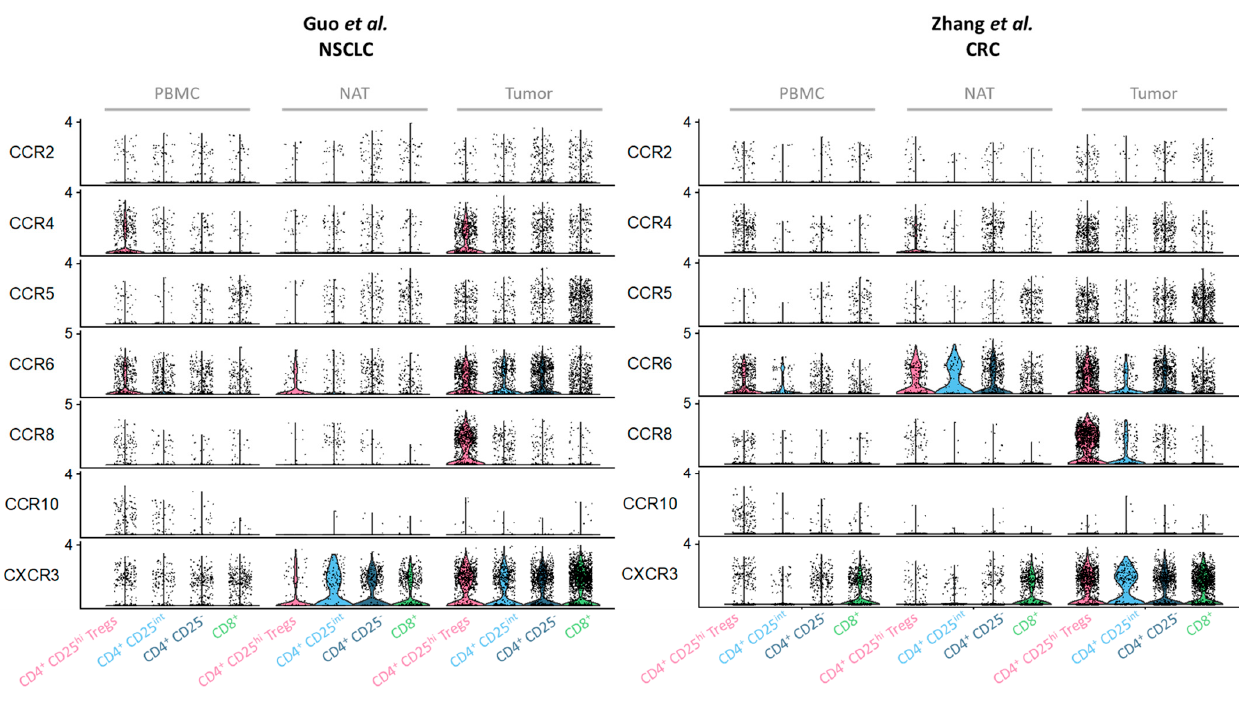
Figure 2. Evaluation of the chemokine receptor expression in human T-cell subsets in non-small cell lung cancer (NSCLC) and colorectal carcinoma (CRC) single-cell RNA sequencing (scRNA-seq) public datasets. Public scRNA-seq datasets of T cells issued from blood (PBMC), normal adjacent tissue (NAT) and tumor tissues of NSCLC patients (GSE 99254 and SMARTSeq2) [44] and CRC patients (GSE 108989 and SMARTSeq2) [65] were reanalyzed using bioinformatic tools based on the same clusters as described by the authors (pink: Tregs, sky blue: activated CD4 + Teff, dark blue: nonactivated CD4 + T cells and green: CD8 + T cells). Reprinted with permission from ref [44] and [65]. Copyright 2021 Guo, X and Zhang, Y.